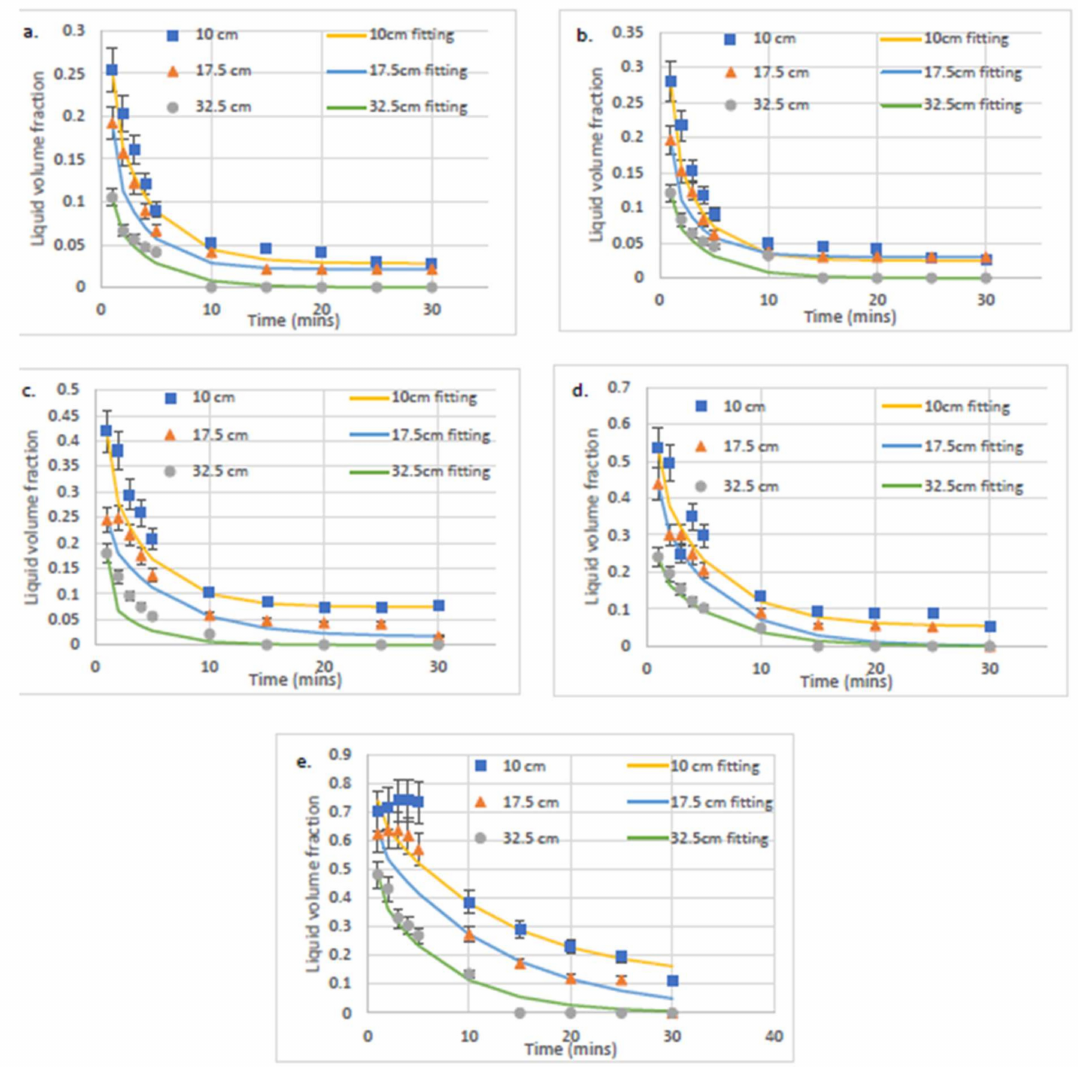
Figure 11. Dependency of liquid volume fraction with time of foam at each height for SDS solutions diluted with distilled 15dH hard water with concentrations ( a ) 0.5 CMC, ( b ) 1 CMC, ( c ) 10 CMC, ( d ) 20 CMC, and ( e ) 50 CMC. The fitting is according to Equation